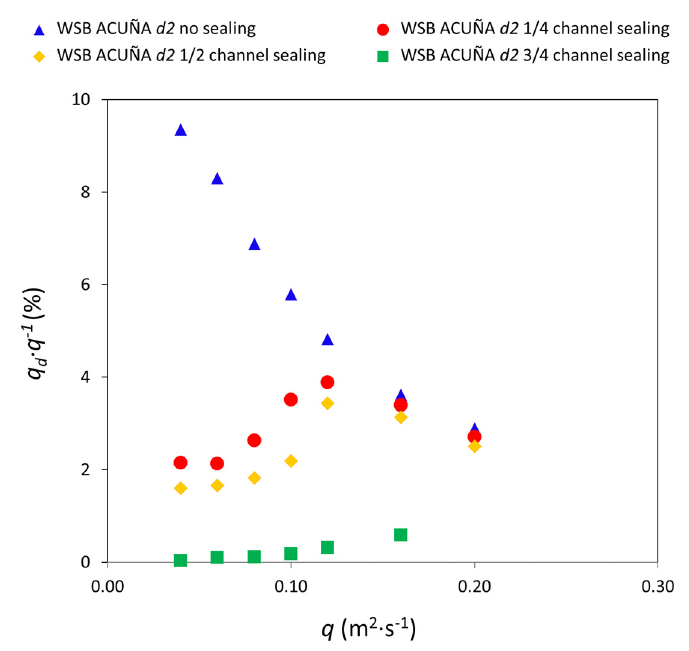
Figure 25. The unit flow rate through the drainage layer ( q d ) expressed as a percentage of the flow rate ( q ) for different q and joint-sealing